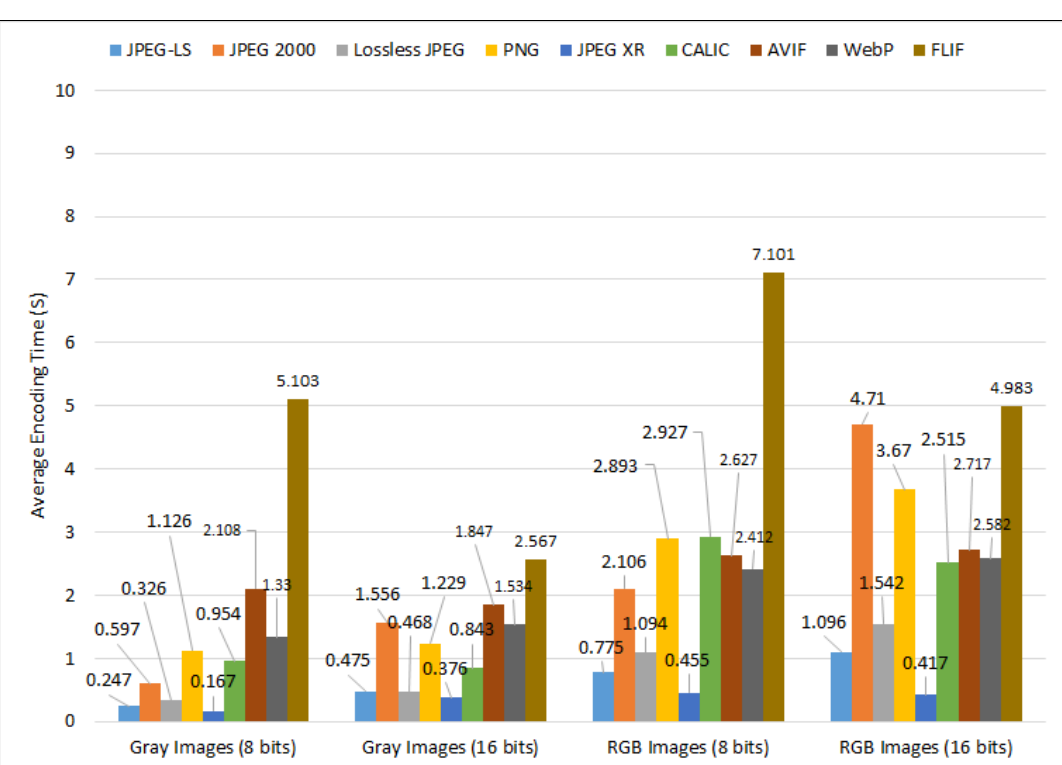
Figure 26. Comparison of average compression ratios.